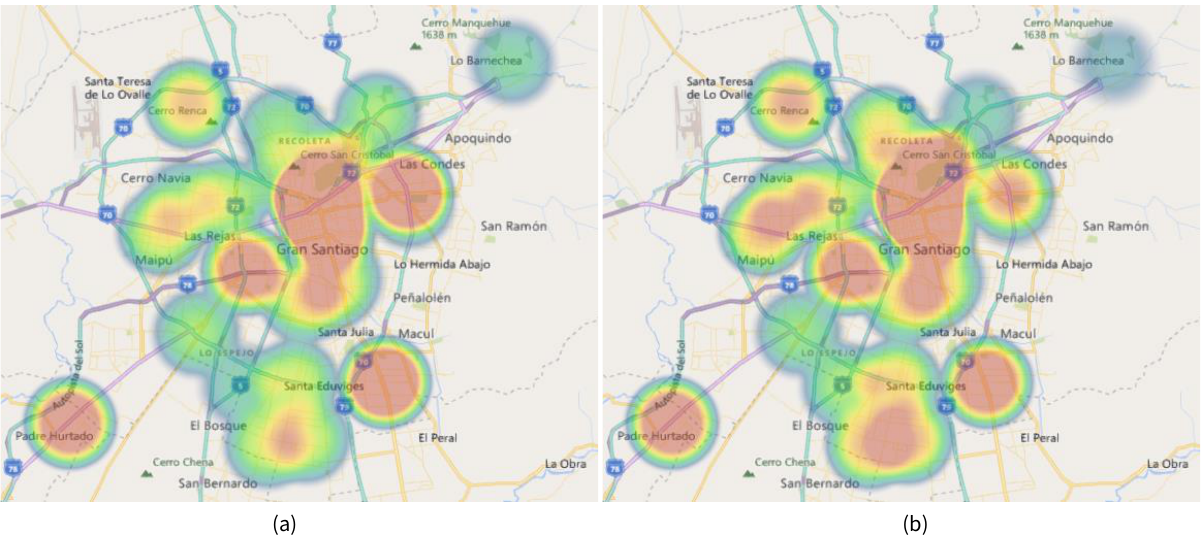
Figure 6. Percentage distribution of events violent crimes (a), vehicle theft (b), theft in habited place (c) and fatalities (d) with respect to the total news of criminal events recovered